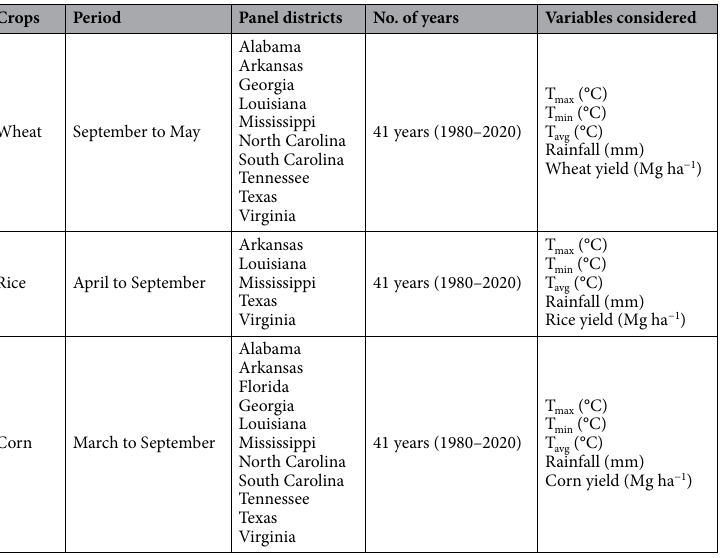
Table 1. Description of the explanatory and response variables used in the fixed effect panel